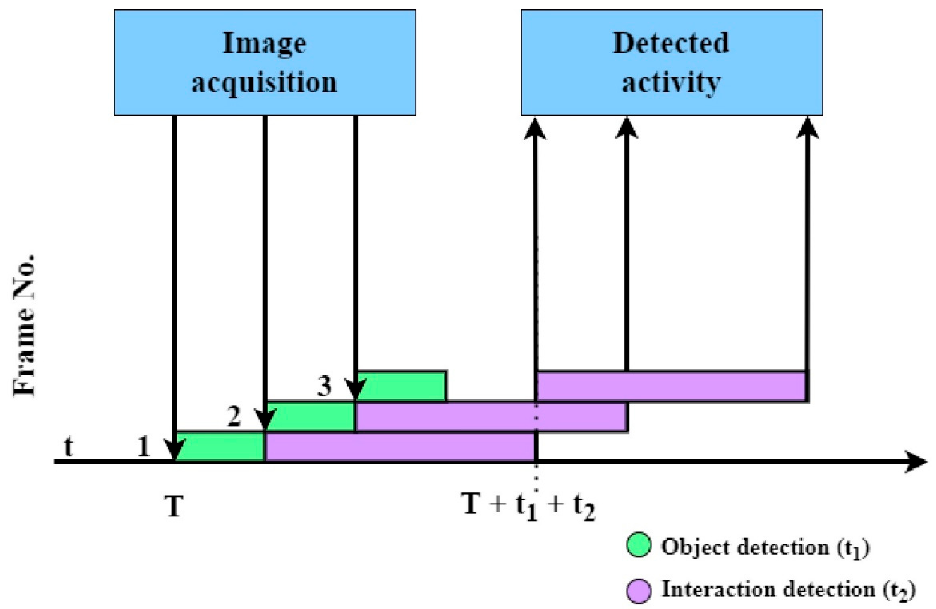
Figure 17. Configuration using two threads.